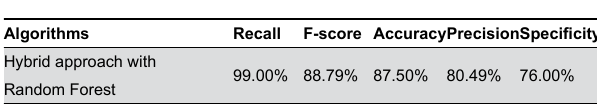
Table 7. Performance of the hybrid approach using a separate testing set T after the named entity